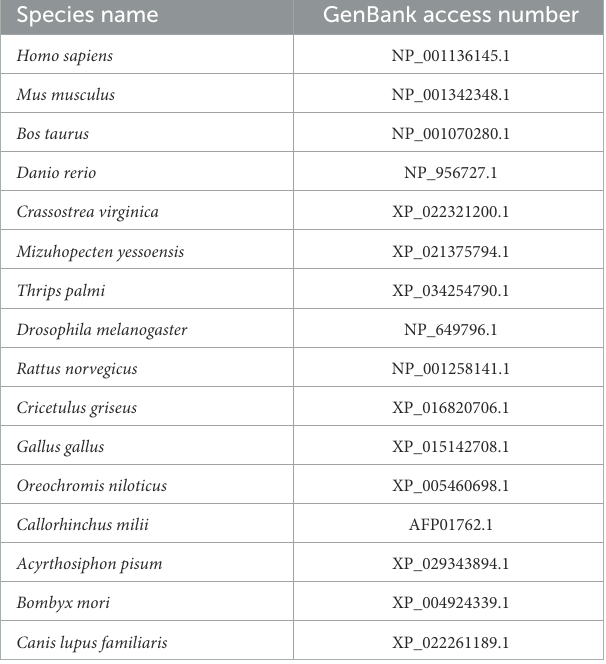
TABLE 2 The GenBank access numbers of ATG13 homologs used in multiple sequence alignment and phylogenetic tree